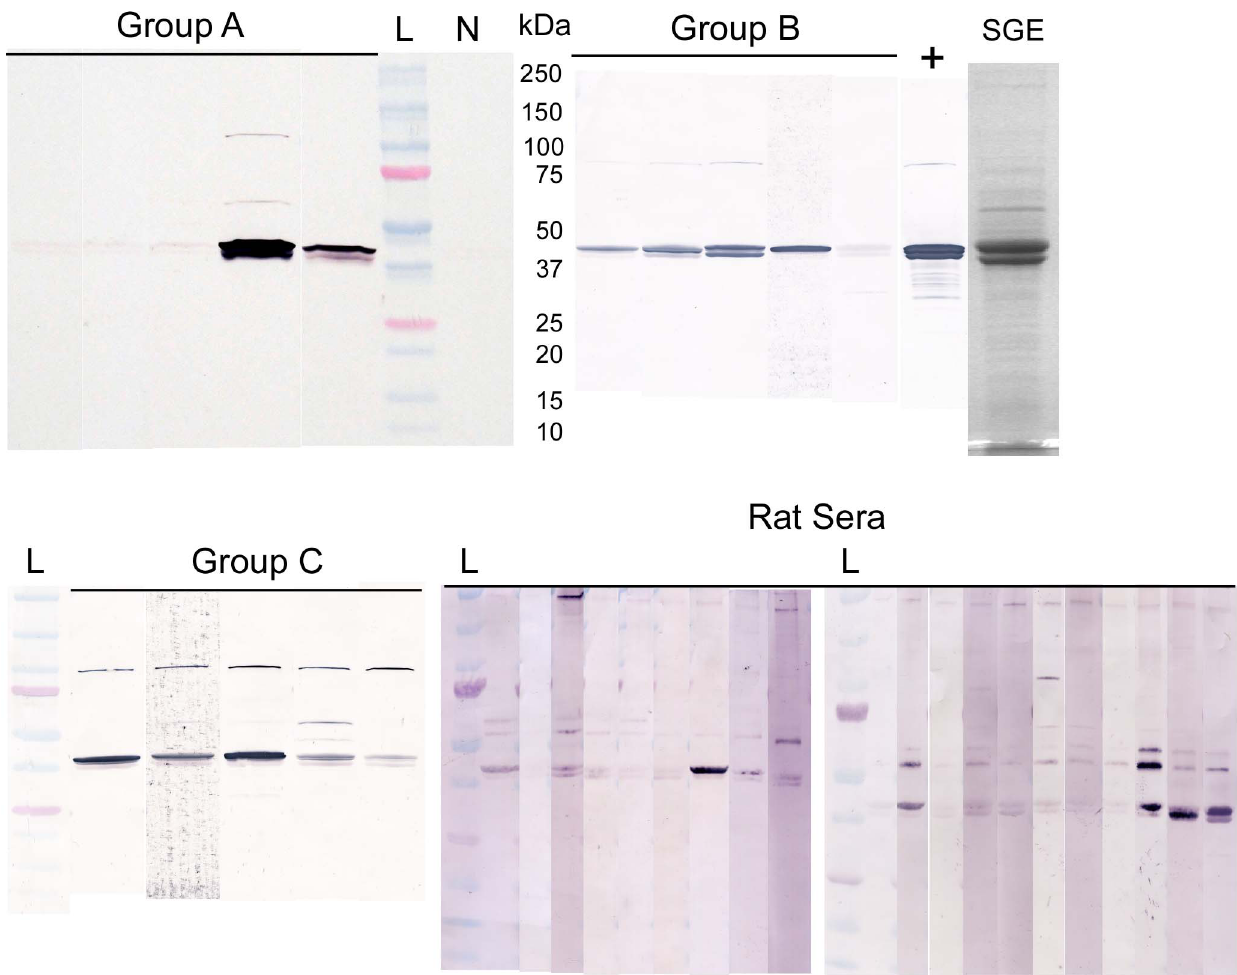
Figure 5. Serum IgG responses to flea SGE in mice and rats previously exposed to flea bites. ( A – C ) Immunoblots of X. cheopis SGE probed with sera from 5 mice previously exposed over a ten-week period to: ( A ) 25 fleas once per week, ( B ) 50 fleas once per week, or ( C ) 25 fleas twice per week. (Mouse groups A, B, and C, respectively; see Table 1 for details.) ( D ) Immunoblot results from sera of 20 wild Rattus norvegicus trapped in Los Angeles, where rats are naturally infested with X. cheopis fleas. Brackets indicate the position of the 36–45 kDa phosphatase-like proteins, the major component of flea saliva. All sera were tested at a dilution of 1:250, negative control serum from an unexposed C57BL/6 mouse at 1:250; + =positive control mouse serum at 1:10,000; SGE=Coomassie stained SDS-PAGE of salivary gland extract. Molecular weights (kDa) of protein standards (M) are indicated at left.